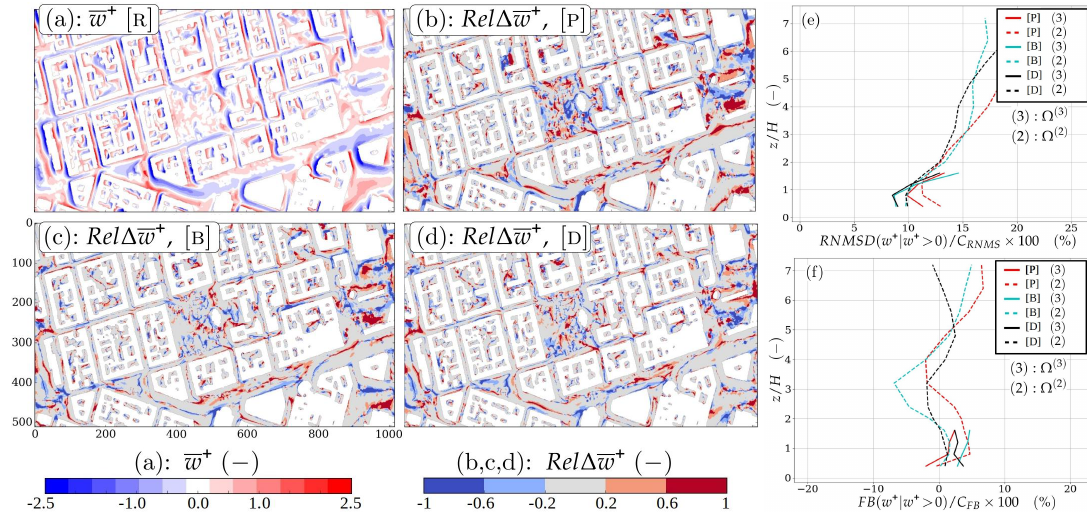
Figure 8. ( a ) Horizontal distribution of w + at z = 0.35 H . ( b – d ) Relative difference distributions between cases [P] , [B] , and [D] . ( e ) Vertical variation of conditional root-normalized-mean-square difference RNMSD ( w + | w + > 0 ) and ( f ) conditional fractional bias FB ( w + | w + > 0 ) evaluated over 12